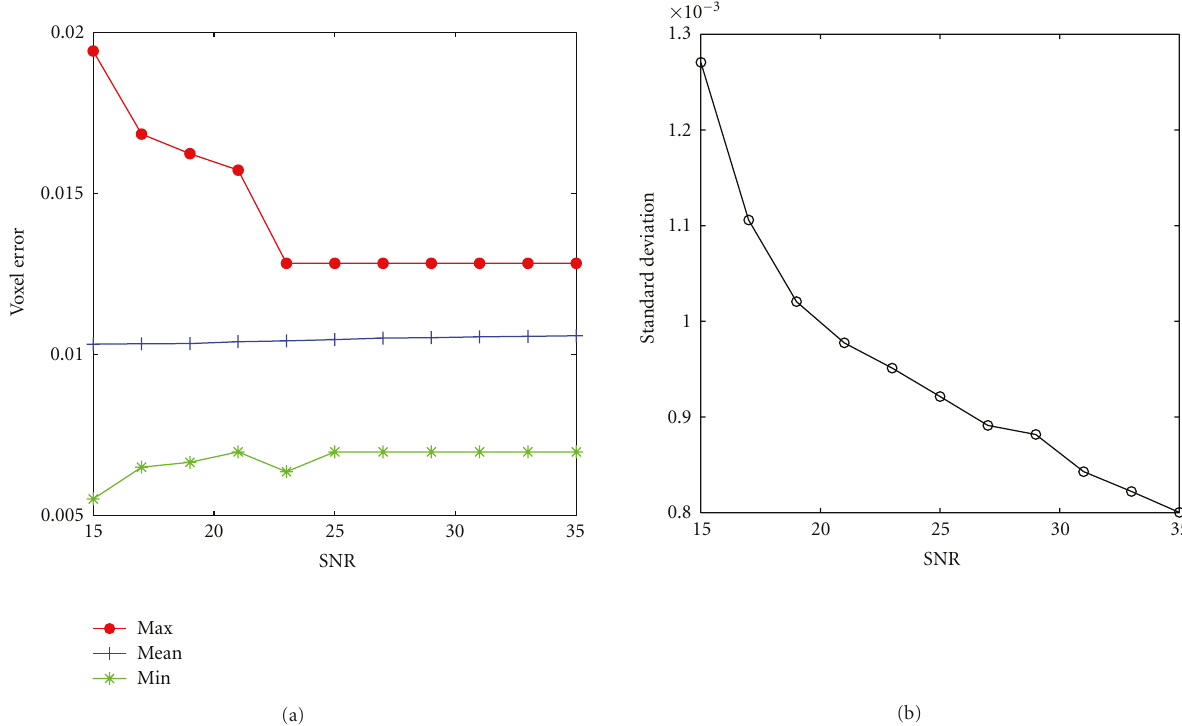
Figure 9: Results for SNR 15 up to 35 using T = 0 . 32. (a) The maximum (red dotted line), the mean (blue crossed line), and the minimum voxel error plotted against SNR, and (b) the standard deviation plotted against